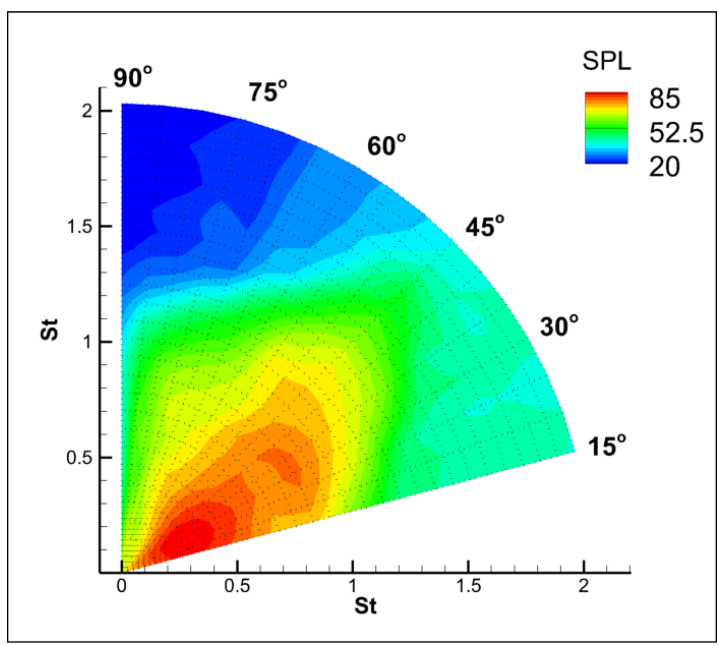
Figure 12. Farfield sound pressure levels along a polar arc at 75